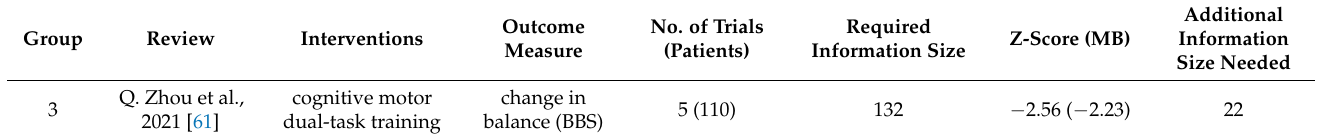
Table 5. Studies with firm evidence of an effect on balance function